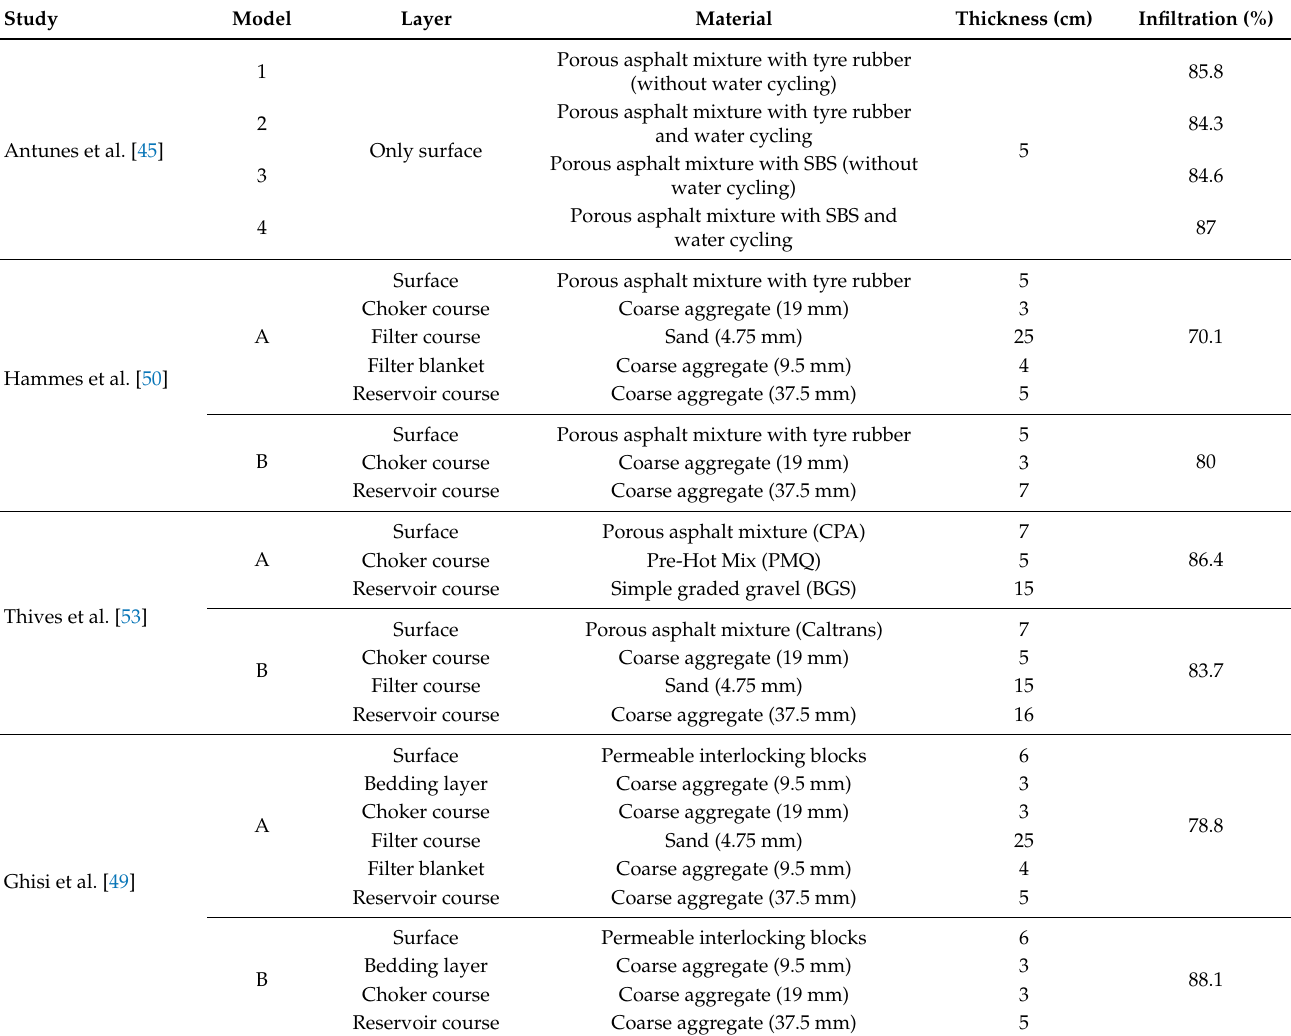
Table 3. Layers, materials, thicknesses and infiltration of the analysed